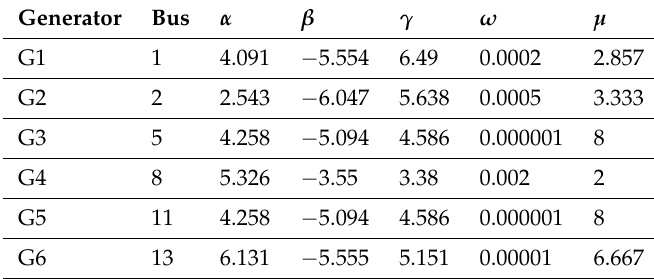
Table 1. Emission coefficients of thermal power generating units.